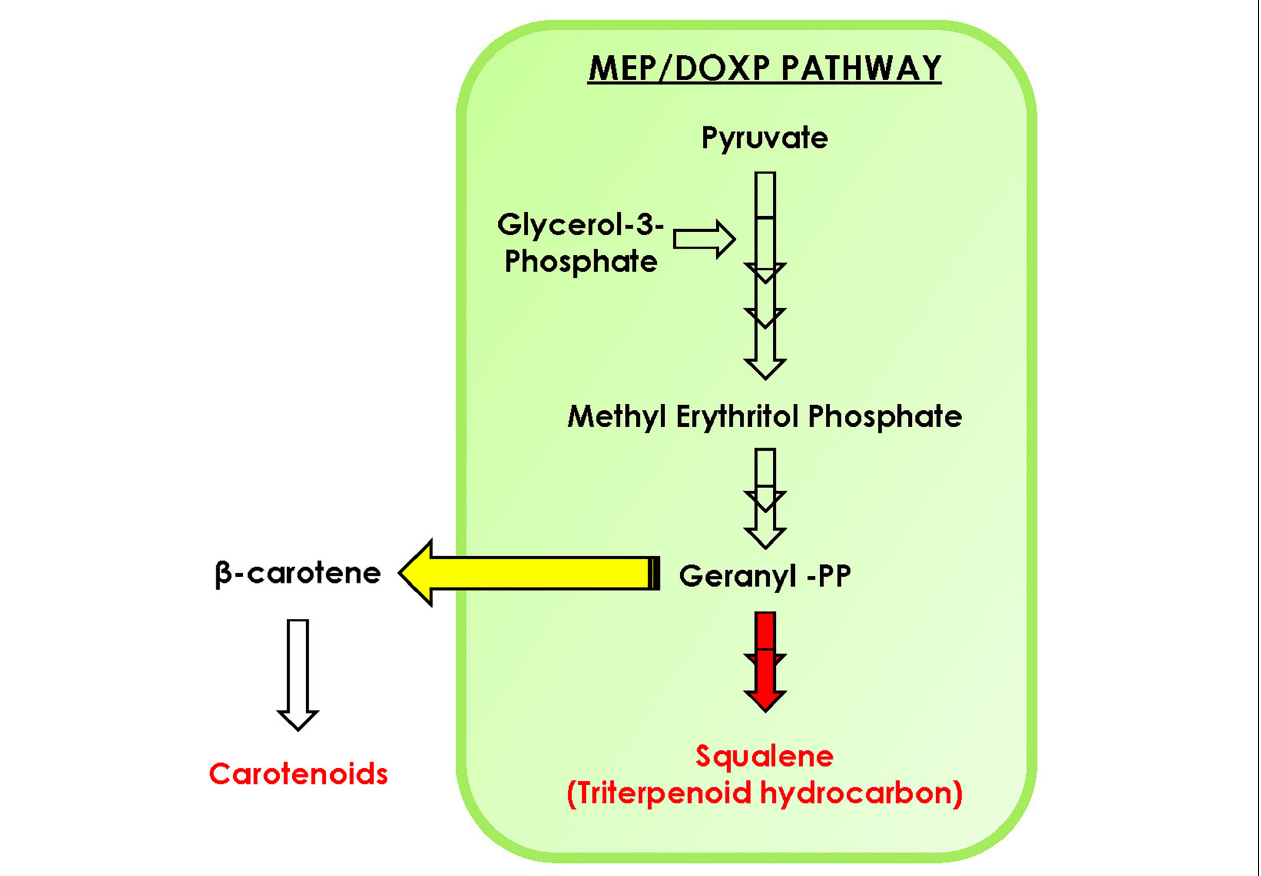
FIGURE 8 | Schematic representation of carotenoid and squalene biosynthesis in Botryococcus braunii . Yellow arrow indicates the diversion toward carotenoids, while red indicates downregulation of squalene production upon carbon